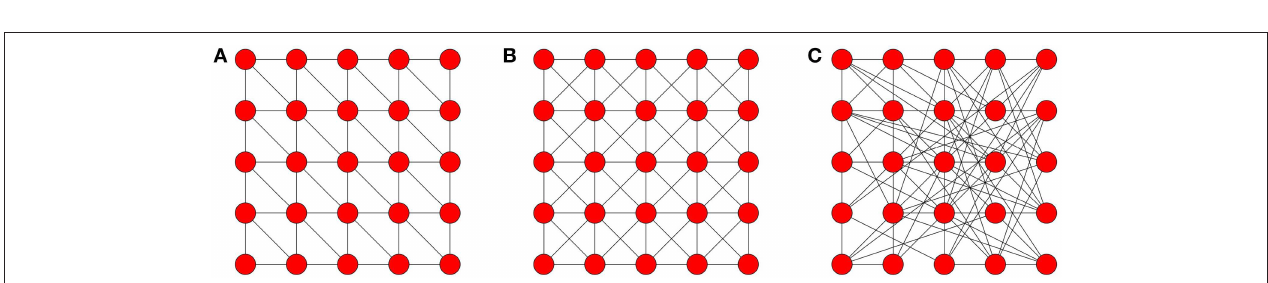
1 ; (B) β 3 ; (C) β 4 ; (D) β 10 . Parameters ρ 0 , N and dt are as in Figure 6 . = = = =